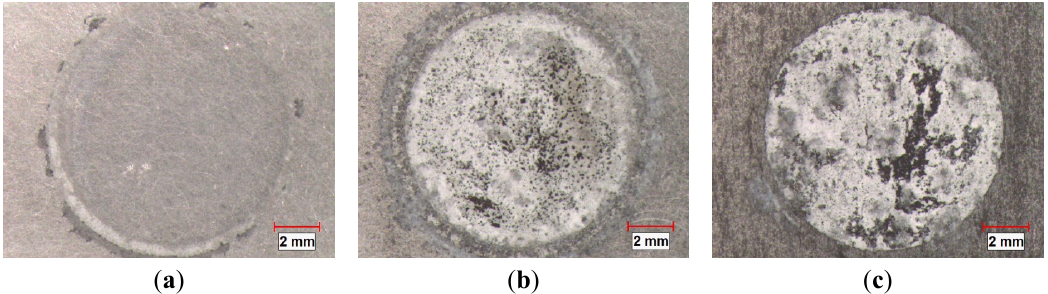
Figure 10. Stereoscope graphs showing the corroded surface morphology of ( a ) AA1100; ( b ) AA1100-16 vol.% B 4 C and ( c ) AA1100-30 vol.% B 4 C immersed in 3.5 wt.% NaCl solution for 10 days.